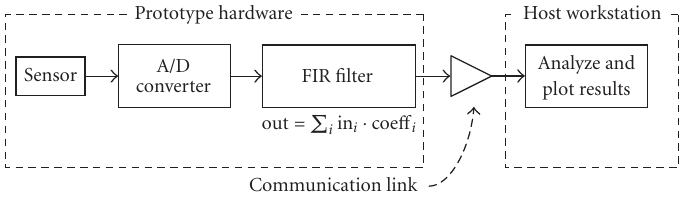
Figure 3: A sketch of the system, showing selected blocks executing on the prototype hardware, while the remaining blocks execute on the host workstation. Note the addition of a communication link, automatically inserted by the simulation/prototype